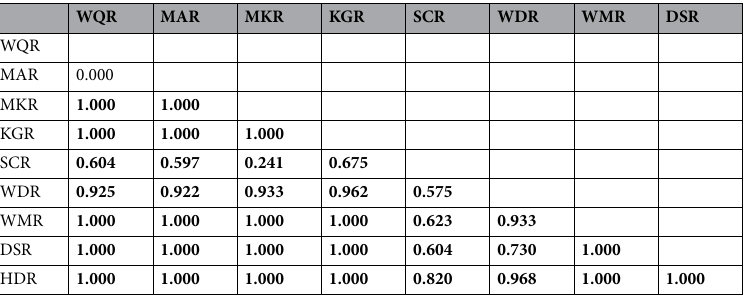
Table 4. Pairwise ɸ ST values among the S . lissolabiatus populations based on Cytb . The values in bold are significant at P < 0.05. The location abbreviations are presented in Table